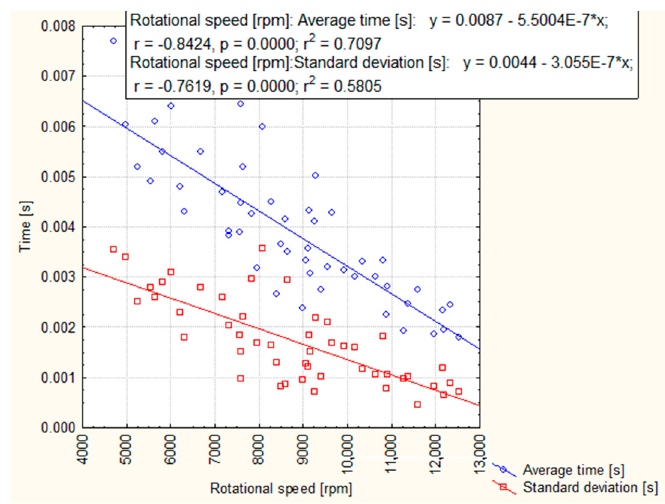
Figure 11. Relationship of the average cutter engagement time and its standard deviation with the rotational speed of the chainsaw engine.